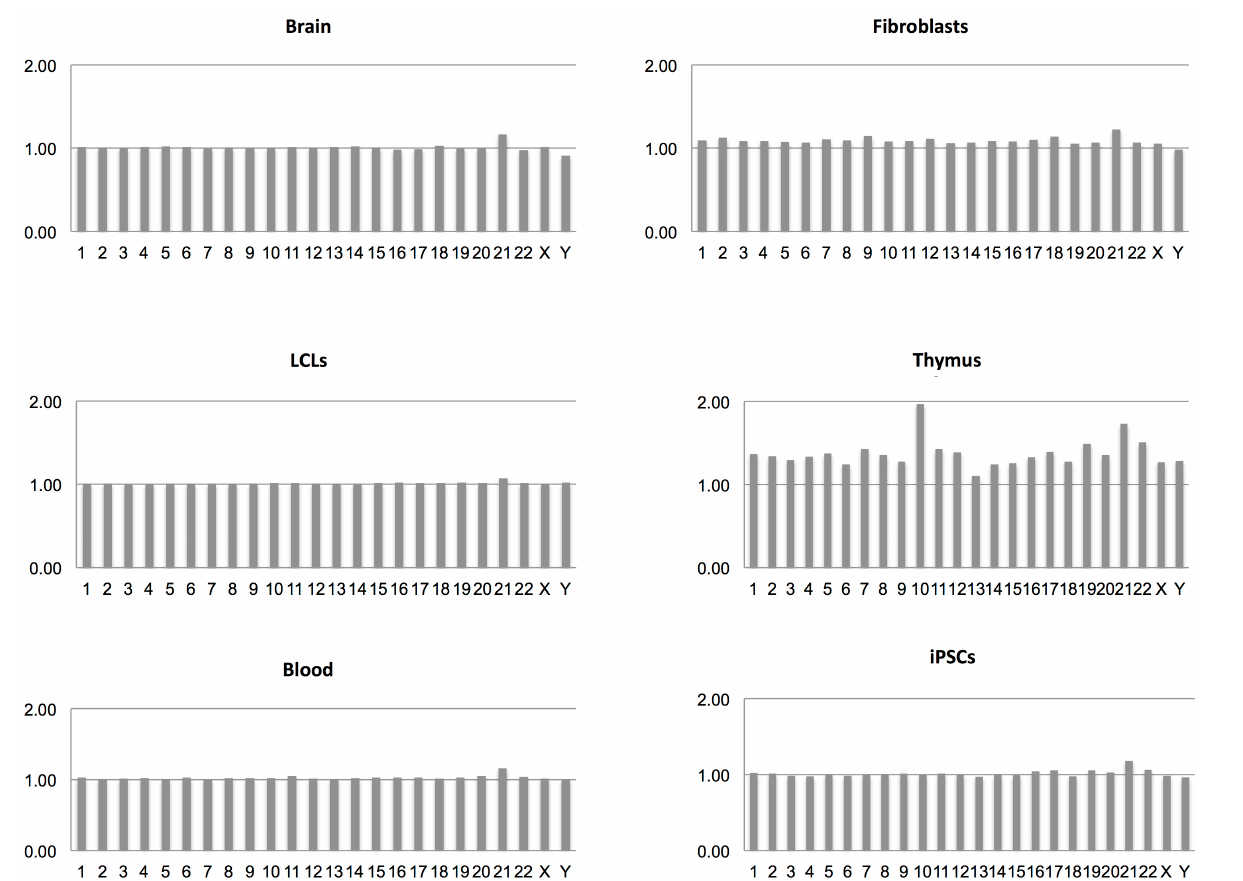
FIGURE 2 | DS/normal expression ratio for each chromosome in terms of mean expression level derived from all the genes on that chromosome in each transcriptome